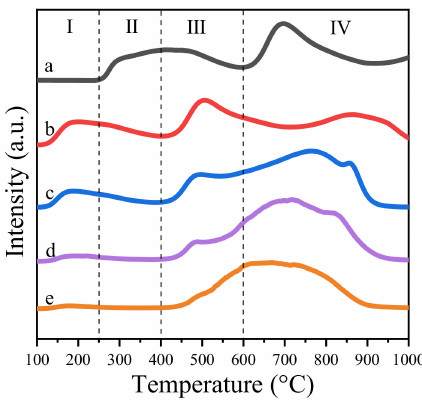
Figure 6. CO 2 -TPD profiles of Zn-Mg-Al mixed oxides-supported gold catalysts: ( a ) Au 25 /MgAl-400; ( b ) Au 25 /Zn 0.05 MgAl-400; ( c ) Au 25 /Zn 0.33 MgAl-400; ( d ) Au 25 /Zn 3 MgAl-400; ( e ) Au 25